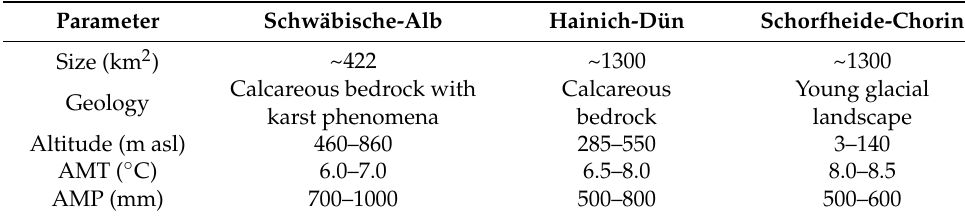
Table 1. Geographical, topological and climatic characteristics of the three study regions included in the Biodiversity Exploratories project after Fischer et al. [21]. Abbreviations: AMT: Annual Mean Temperature, AMP: Annual Mean Precipitation, asl: above sea level.